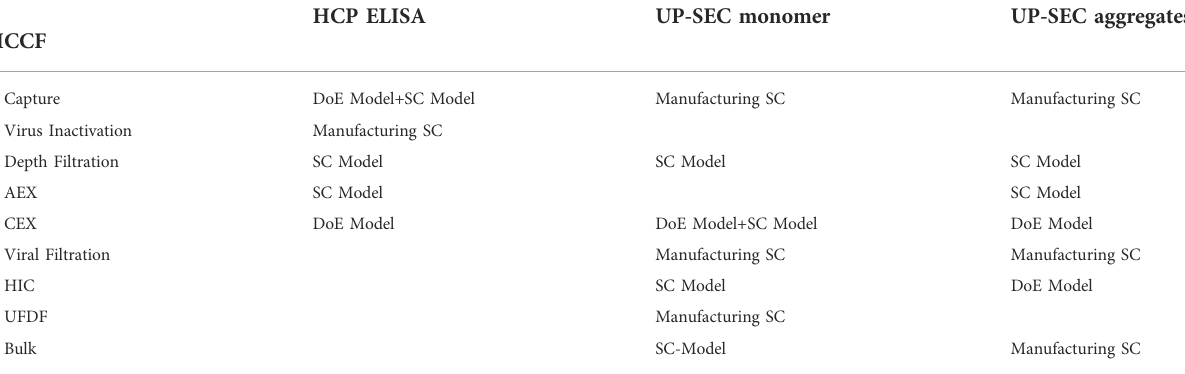
TABLE 2 Summary of models used for modelling each unit operation and each CQA. Models describing the speci fi c clearance as function of process parameters are termed “ DoE Model ” . Models describing the speci fi cation clearance as function of the input material are termed “ SC Model ” . If neither a functional relationship of speci fi c clearance on process parameters nor on the input material was found, the unit operation was described by the speci fi c clearance observed in manufacturing, termed “ Manufacturing SC ”